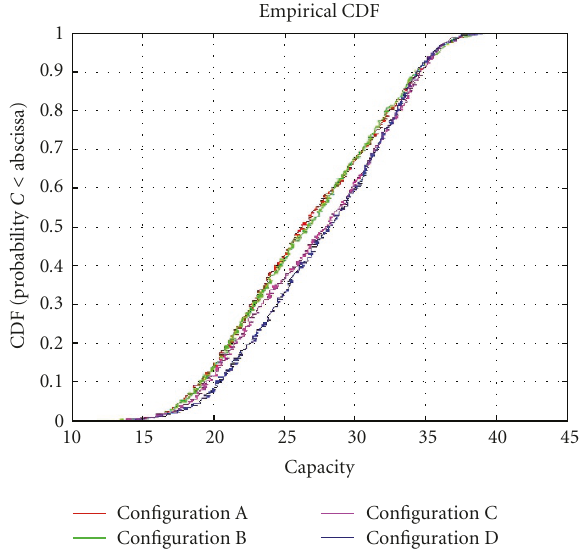
Figure 11: CDF curves of MIMO capacity (measured data) with di ff erent antenna configurations as in Figure 10.